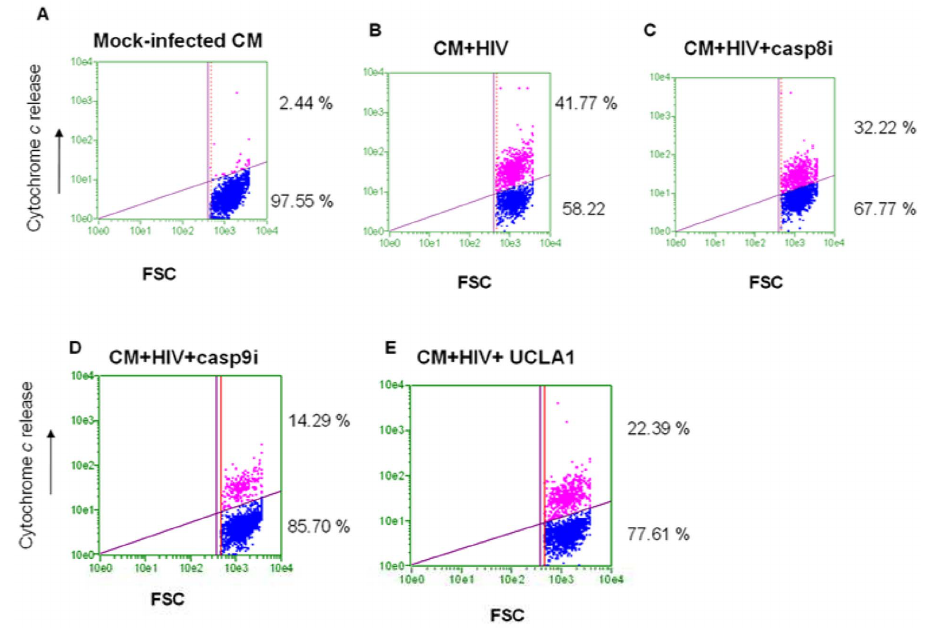
Figure 4. Cytochrome c release in HIV-1 CM9 -infected CM. CM were either (A) mock infected; (B) HIV-1 infected; (C) infected in the presence of casp8i; (D) infected in the presence of casp9i and (E) infected with virus pre-incubated with UCLA1. Data were presented in dot plots relating